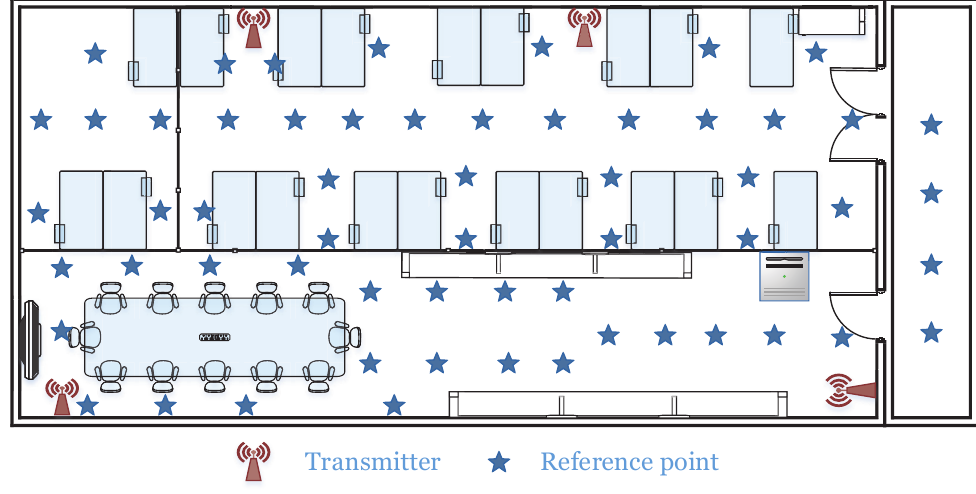
Figure 15. Detailed integrated room